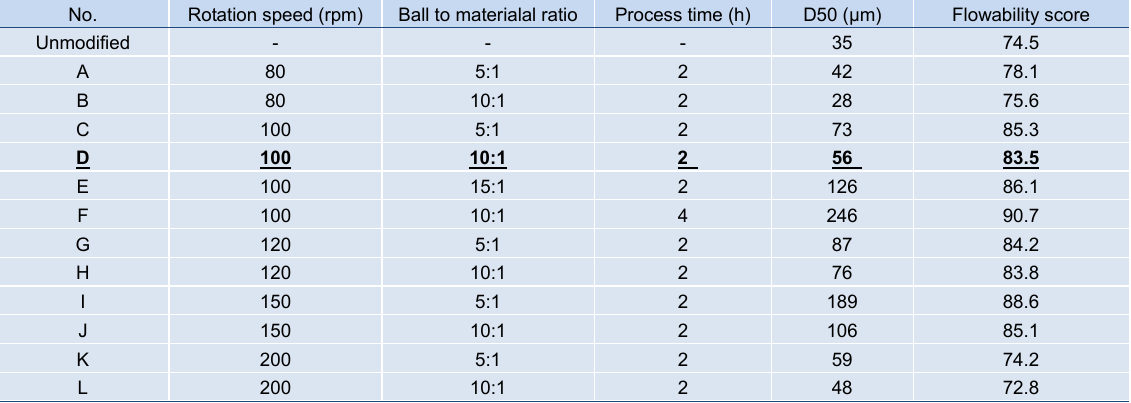
Table 1 | Particle size distribution, D50 and flowability score modified with different parameters . Parameter set No. D (under- lined) shows the best combination of flowability and D50